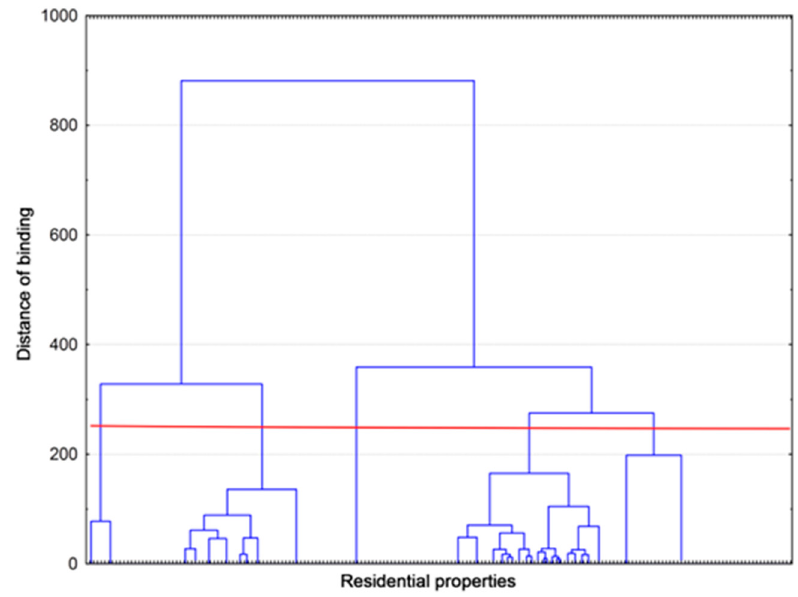
Figure 2. Dendrogram of agglomerative clustering.